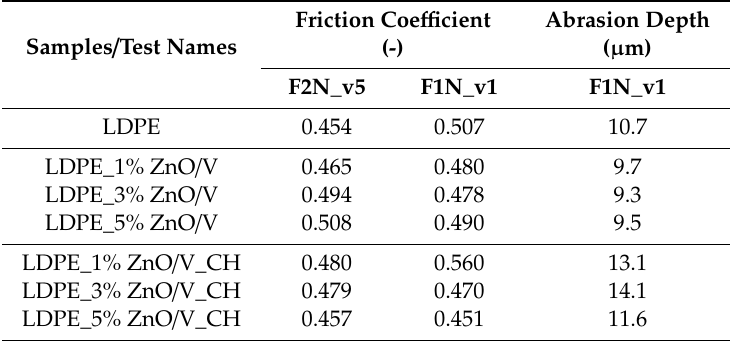
Table 3. The friction coe ffi cients and abrasion depths of the LDPE samples measured for two condition modes, F2N_v5 and